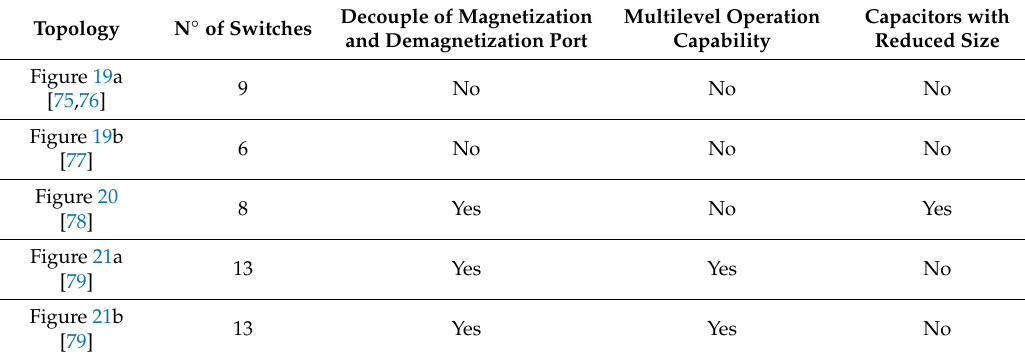
Table 3. Comparative summary of the SRM impedance source